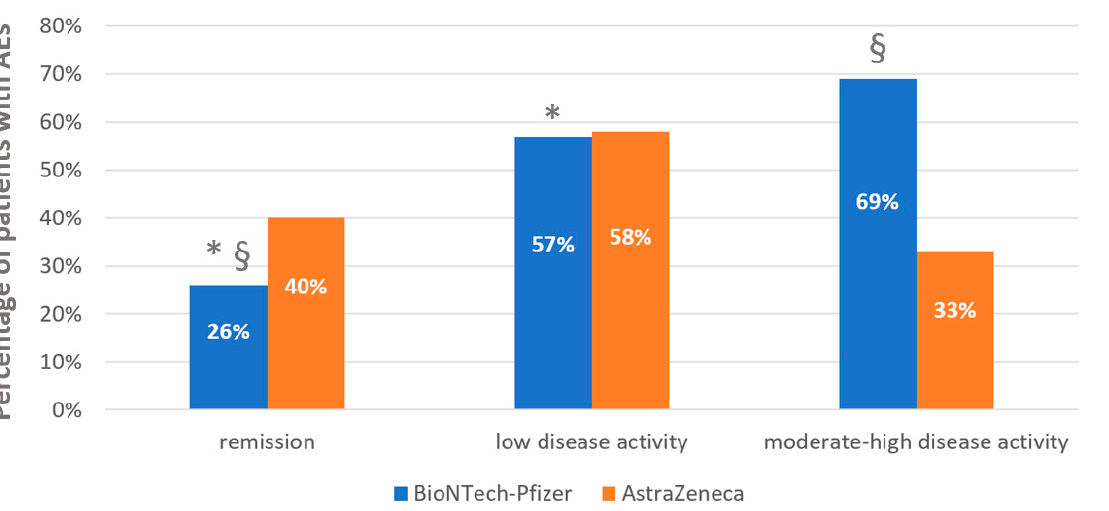
Figure 1. Percentages of adverse events after the first dose of vaccine in autoimmune/chronic inflammatory rheumatic diseases (Au/cIn-RD) stratified for different vaccines in use and disease activity. Data are shown as %. Statistical significance was set at p ≤ 0.05. AEs: adverse events. Number of patients immunized with BioNTech-Pfizer: remission 53, low disease activity 38, moderate-high disease activity 16. Number of patients immunized with AstraZeneca: remission 15, low disease activity 12, moderate-high disease activity 3. AEs in remission patients immunized with BioNTech—Pfizer vs. AstraZeneca p = 0.239. AEs in low disease activity patients immunized with BioNTech–Pfizer vs. AstraZeneca p = 0.597. AEs in moderate-high disease activity patients immunized with BioNTech–Pfizer vs. AstraZeneca p = 0.296. AEs in patients immunized with BioNTech–Pfizer: * remission vs. low disease activity p = 0.001; § remission vs. high disease activity p = 0.001; low disease activity vs. moderate-high disease activity p = 0.567. Patients immunized with AstraZeneca: remission vs. low disease activity p = 0.566, remission vs. moderate-high disease activity p = 0.564, low disease activity vs. moderate-high disease activity p = 0.745.